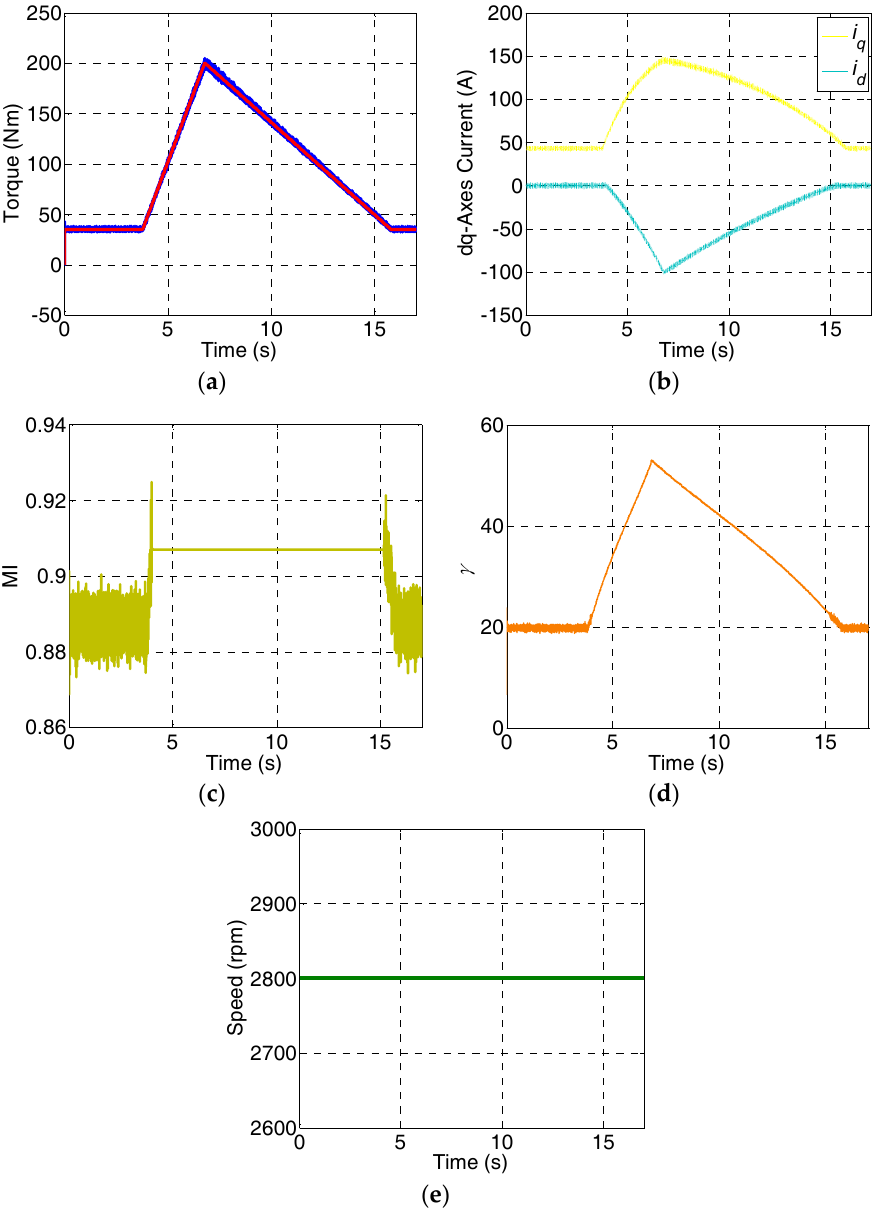
Figure 6. Simulation results of the transition between the constant torque and the FW region with the output torque changing. ( a ) Torque; ( b ) dq-Axes Currents; ( c ) MI; ( d ) γ ; ( e ) Speed.